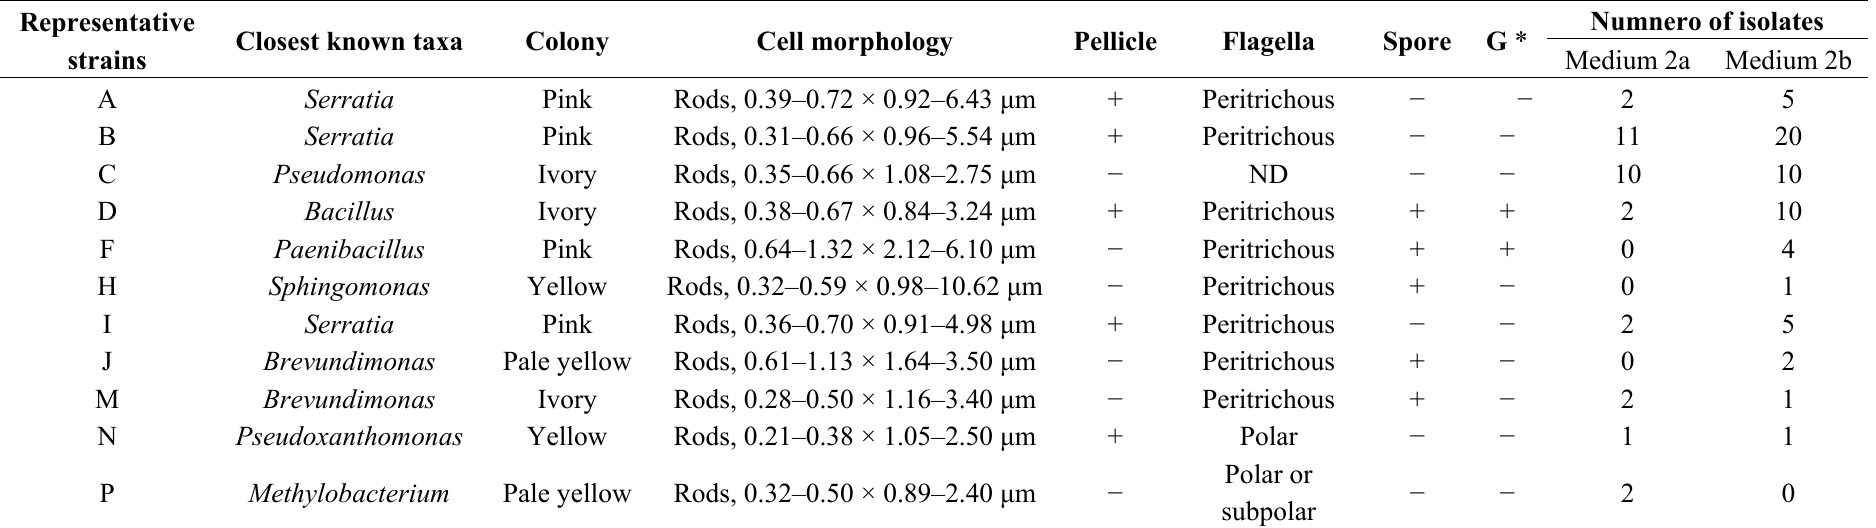
Table 1. Characteristics of cellulose-degrading microorganisms that were separated from guts of D. armandi . +, Positive; −, Negative; ND, no data available; * G, Gram